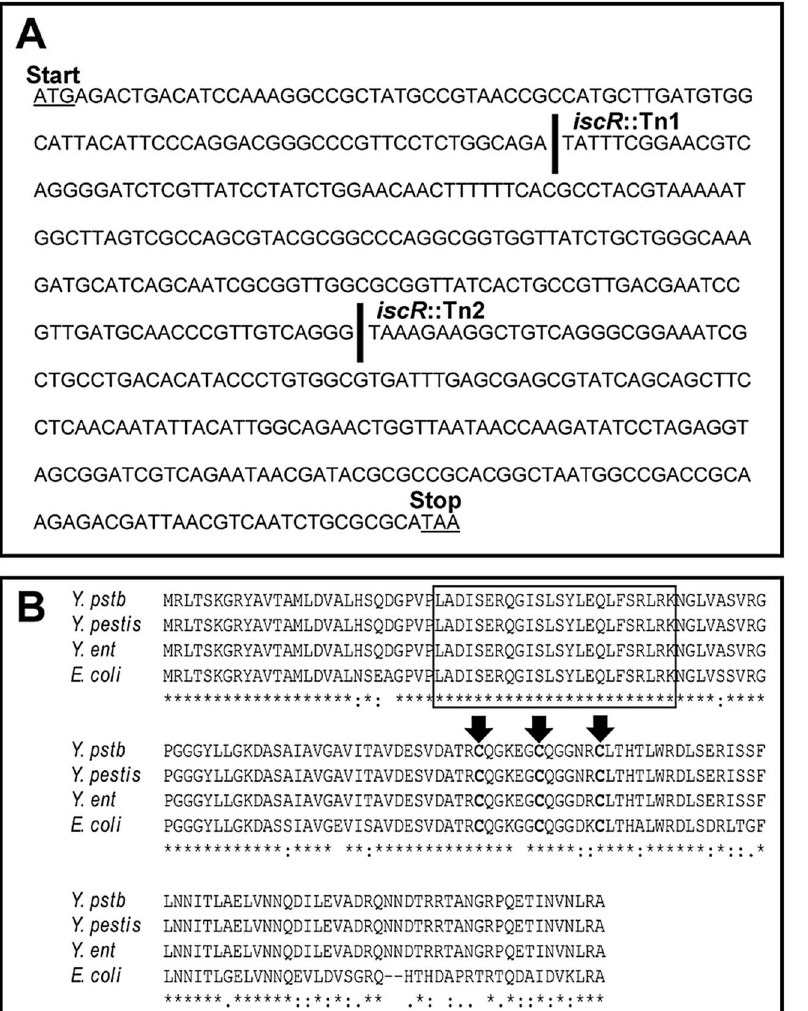
Figure 1. Alignment of protein sequences shows a high level of conservation between E. coli and Yersinia IscR. ( A ) The Y. pseudotuberculosis DNA sequence, which displays the unique insertions sites for the two transposon mutants generated from our genetic screen. A space in the DNA sequence and a solid black line indicate the site of insertion for either iscR ::Tn1 or iscR ::Tn2. ( B ) Multiple sequence alignment was performed on the IscR protein sequence from E. coli K12-MG1655 and each of the three human pathogenic Yersinia spp., Y. pseudotuberculosis IP 32953 ( Y. pstb ), Y. enterocolitica 8081 ( Y. ent ) and Y. pestis CO92 ( Y. pestis ) using ClustalW [86]. The N-terminal helix-turn-helix DNA-binding motif is indicated by a black box. The three conserved cysteine residues (C92, C98 and C104) responsible for coordinating an Fe-S cluster are in bold and identified by black arrows [33]. Asterisks indicate nucleotides that are conserved across all four species.